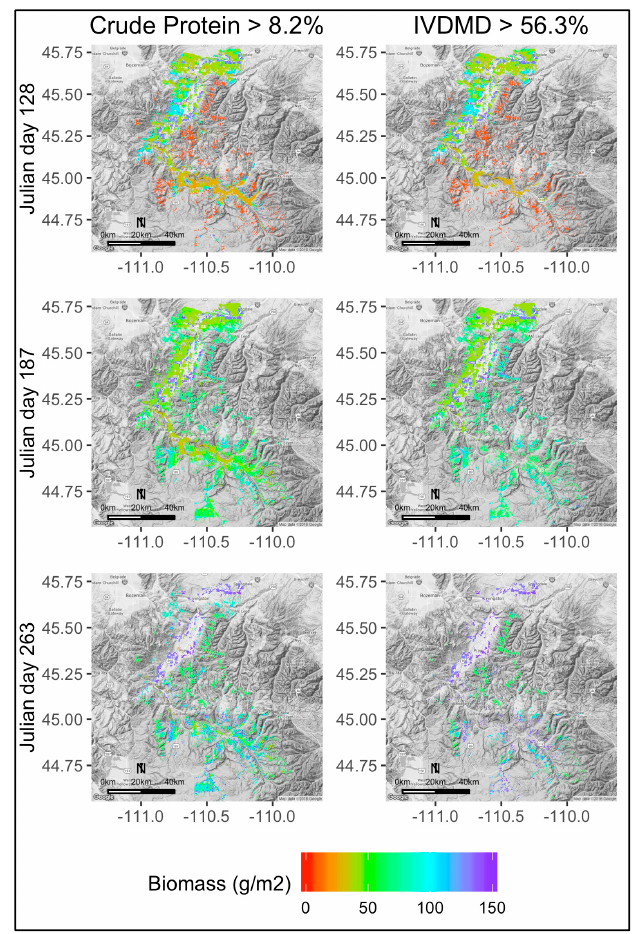
Figure 9. Maps of the abundance of forage with adequate crude protein (>8.2%) and IVDMD (>56 .3%) for elk [38] across the Upper Yellowstone River Basin on Julian days 128, 187, and